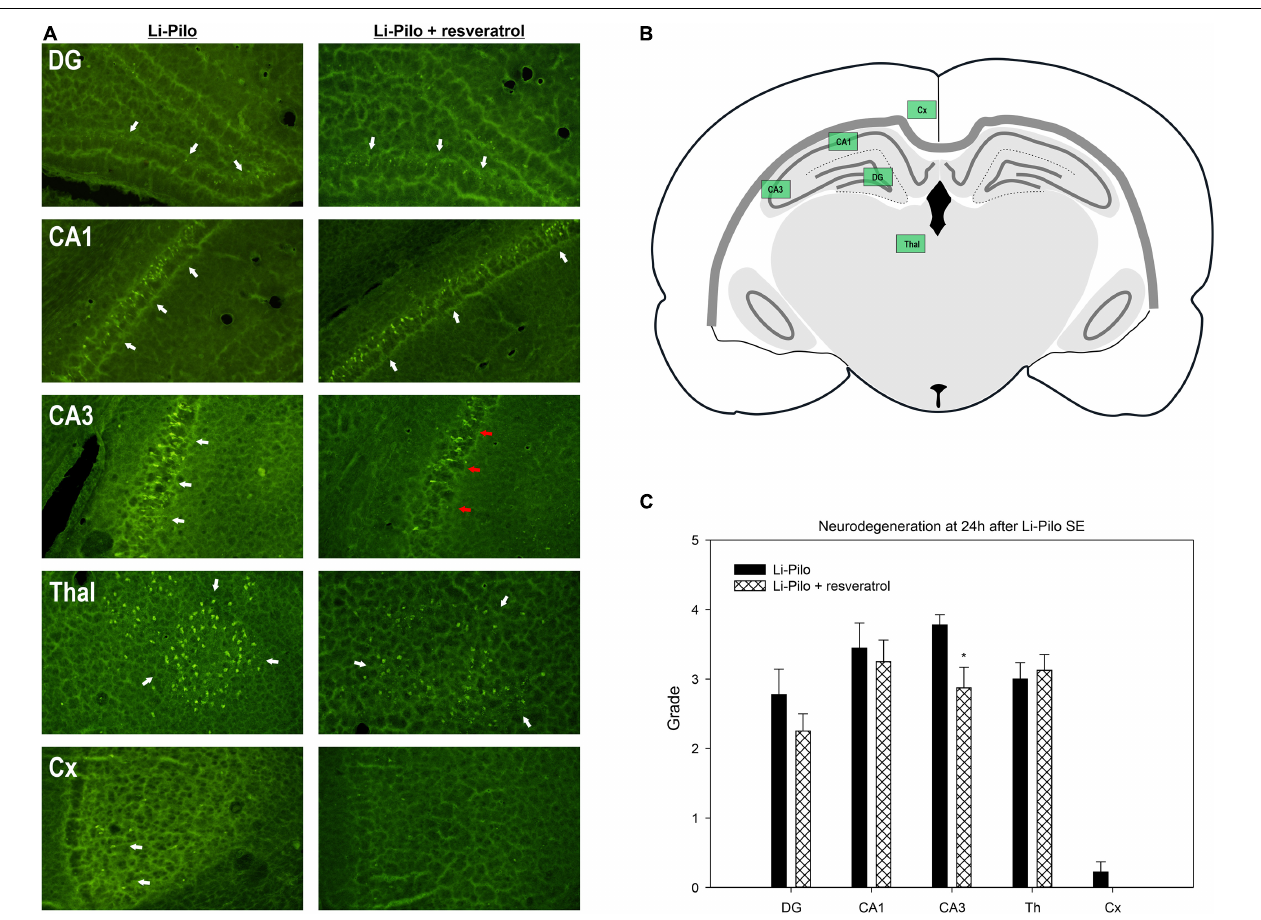
FIGURE 4 | Effect of resveratrol on brain damage. (A) Fluoro-Jade B staining revealed neurodegeneration in the explored regions (white arrows). Resveratrol treatment provided neuroprotective effect in CA3 region (red arrows). (B) Schema of investigated regions. (C) Brain damage evaluated by semiquantitative grading of FJB positive cells (description of score employed is given in the section “Materials and Methods”). * P < 0.05 as compared with Li-Pilo